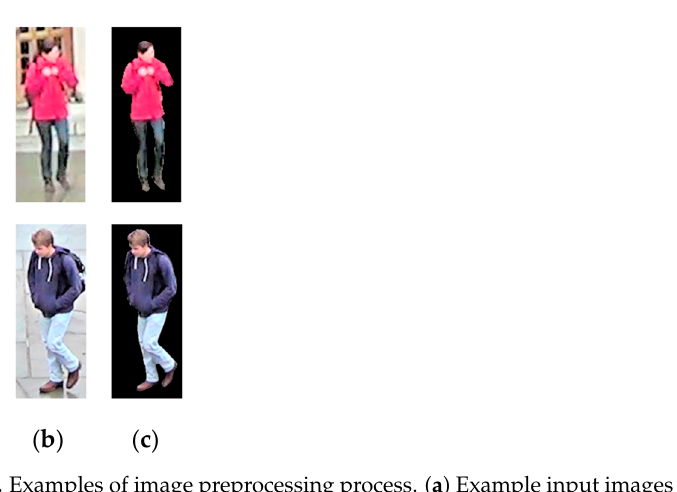
Figure 2. Examples of image preprocessing process. ( a ) Example input images from the DukeMTMC-reID database. ( b ) Processed images by the Retinex algorithm. ( c ) Images after prepro-